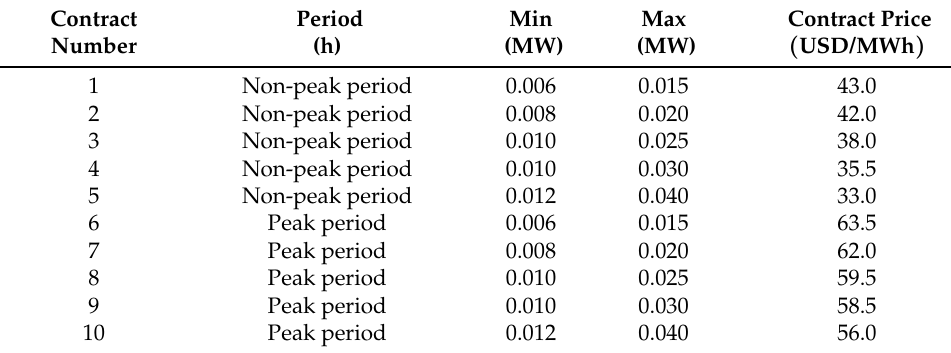
Figure 3. Forecast spot price and distribution system load. Table 2. Bilateral contract